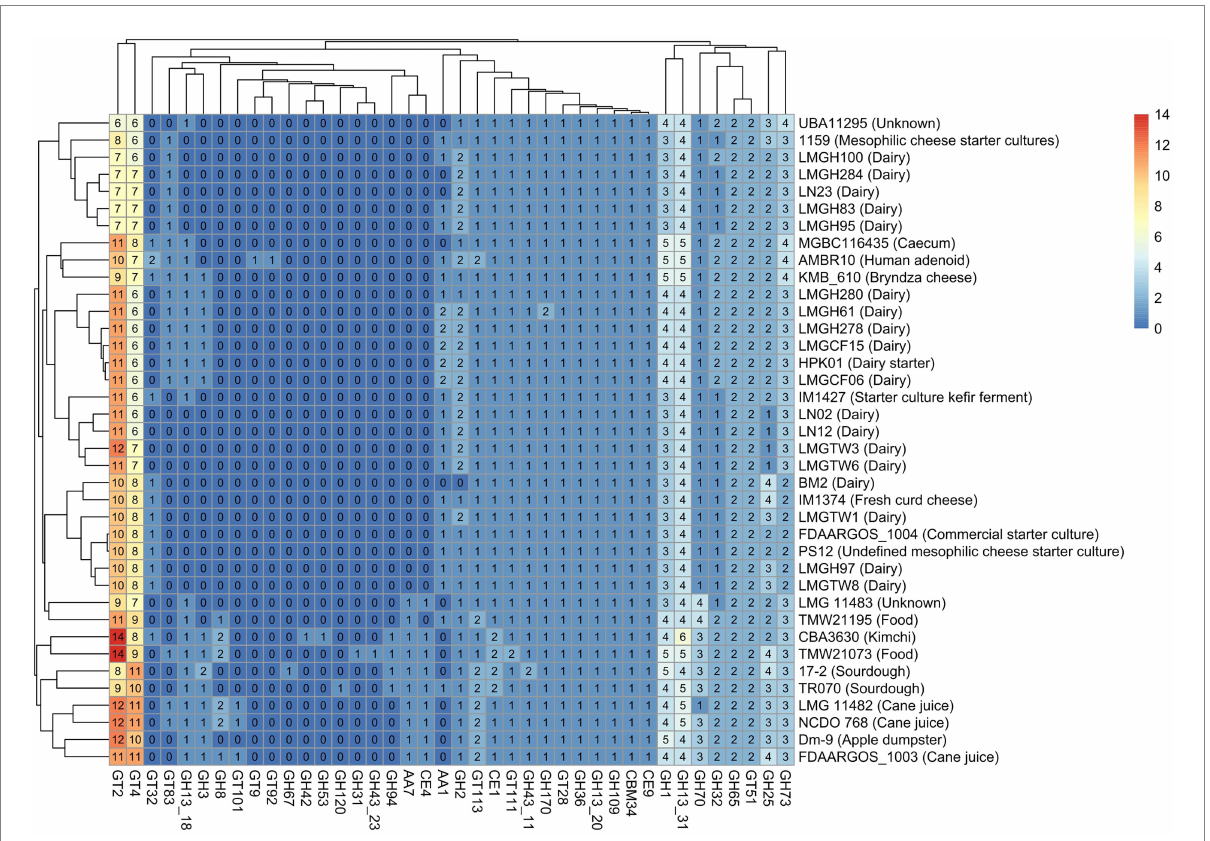
FIGURE 4 Heatmap of CAZymes distribution and clustering across 38 Ln. pseudomesenteroides genomes. The color gradient from lighter to darker colors represent the abundance of CAZymes found in each genome. GH: Glycoside hydrolase, GT: Glycosyltransferase, CE: Carbohydrate esterase, AA: Auxiliary activity, CBM: Carbohydrate binding module. R programming language (version 4.1.1; R Core Team, 2021) was used to draw the